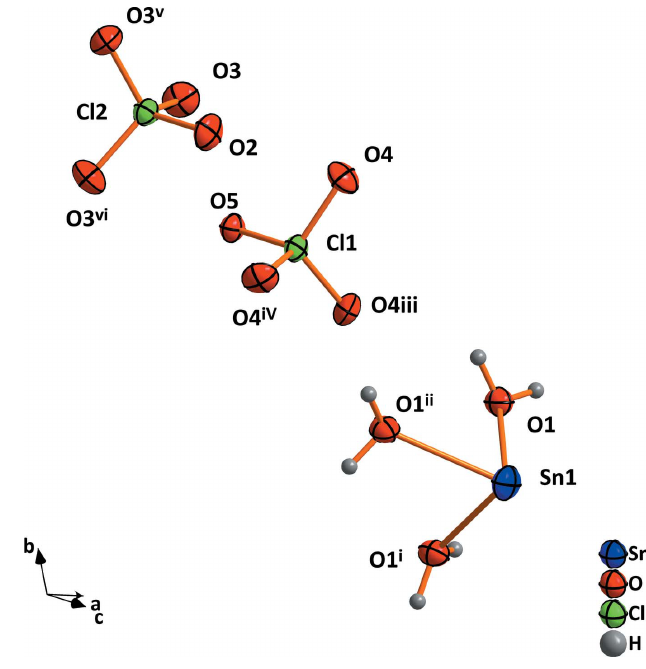
Figure 1 The component ions in tin(II) perchlorate trihydrate with displacement ellipsoids drawn at the 50% probability level. [Symmetry codes: (i) (cid:3) x + y , (cid:3) x , z ; (ii) (cid:3) y , x (cid:3) y , z ; (iii) 1 (cid:3) x + y , 1 (cid:3) x , z ; (iv) 1 (cid:3) y , x (cid:3) y , z ; (v) 1 (cid:3) y, 1 + x (cid:3) y , z ; (vi) (cid:3) x + y , 1 (cid:3) x , z